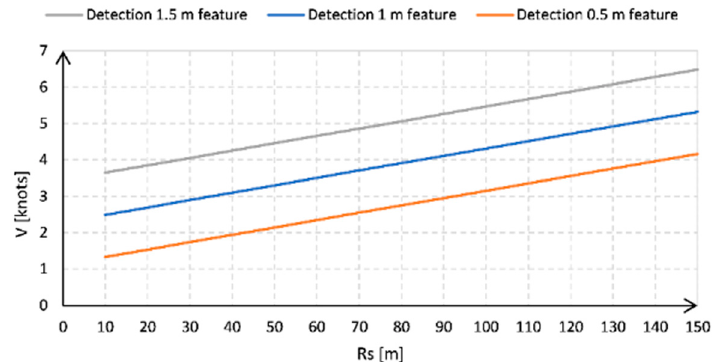
Figure 7. Maximum sonar towing speeds as a function of detection distance for objects of three different lengths and sonar operating range R = 150 m (high resolution channel f = 500 kHz; sound speed c = 1430 m/s; horizontal beamwidth θ h = 0.5 °).